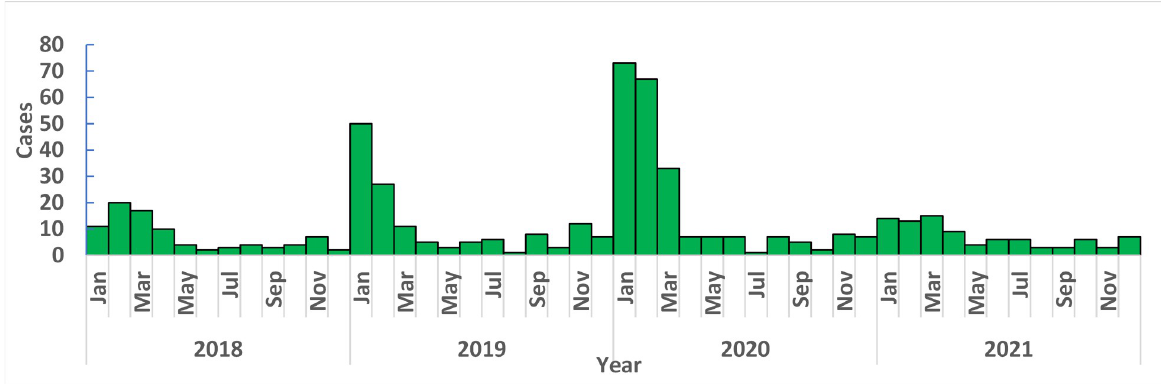
Fig 1. Epicurve of monthly distribution of Lassa fever cases in Nigeria, 2018–2021.